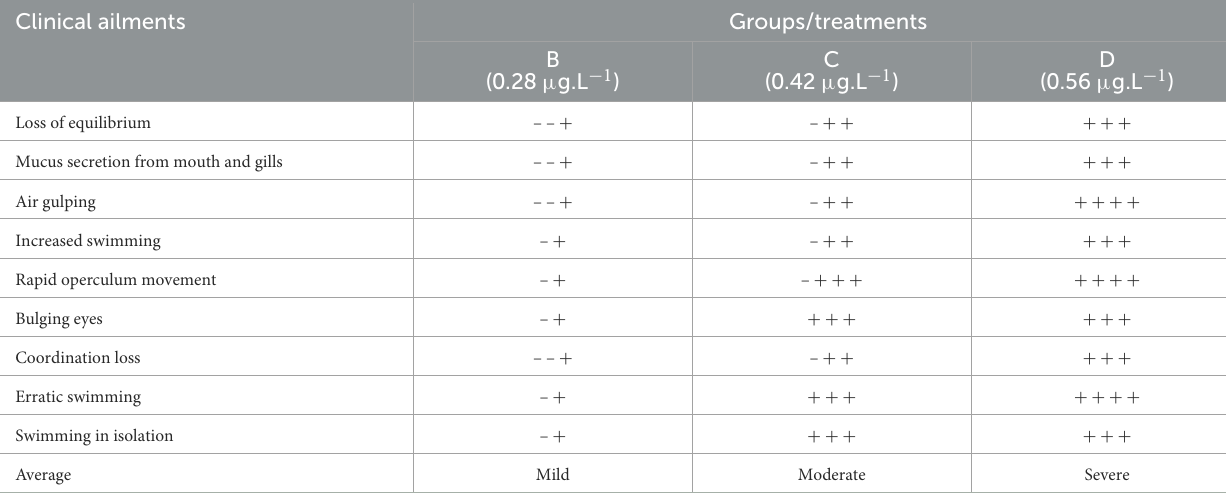
TABLE 1 Intensity of various clinical signs exhibited by the Labeo rohita treated with various concentrations of copper sulfate. Clinical ailments